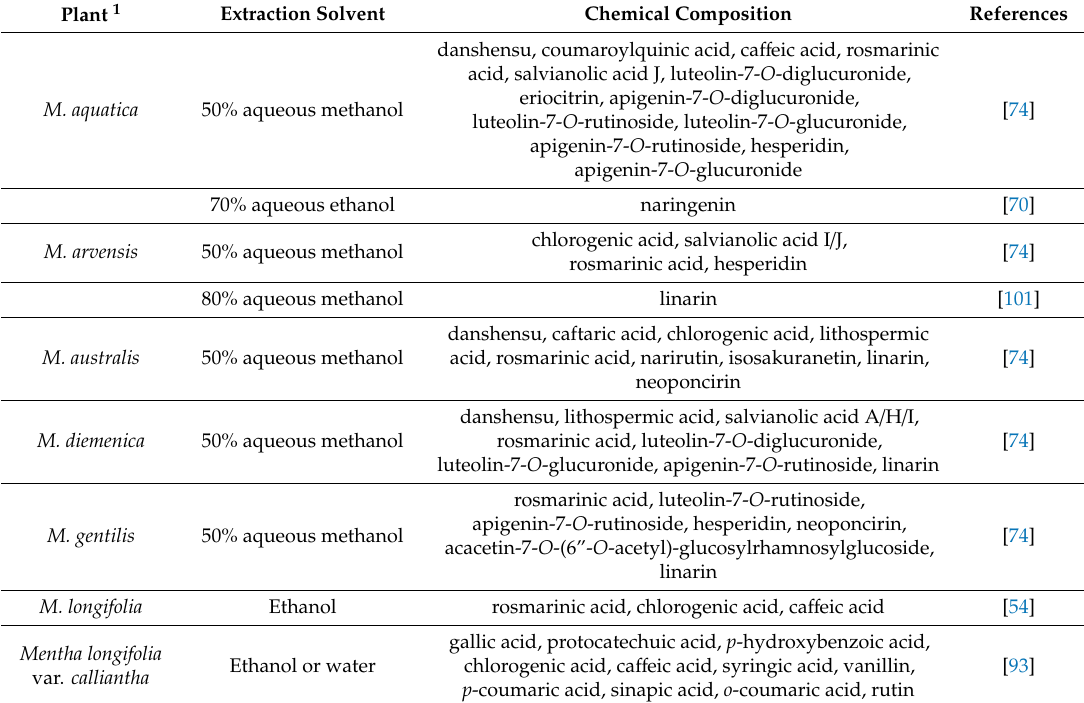
Table 1. Chemical composition of some Mentha extracts that showed activities relevant to CNS, oxidative stress and